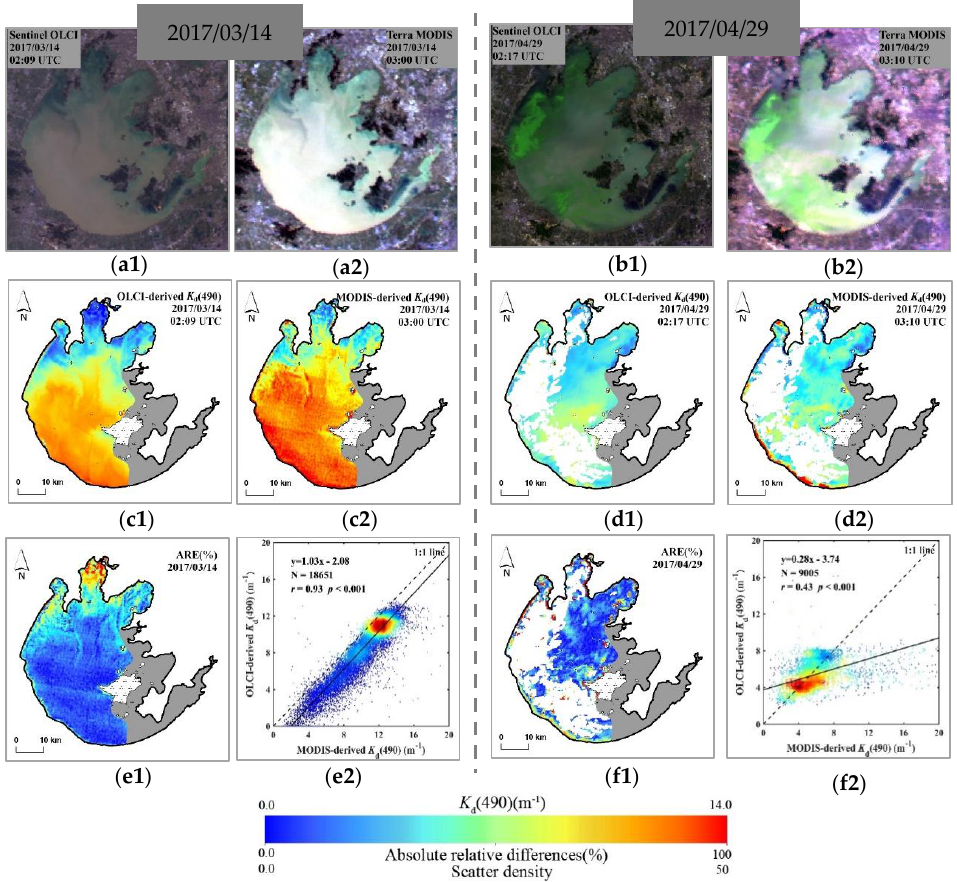
Figure 13. ( a , b ) OLCI and MODIS RGB images, ( c , d ) OLCI- and MODIS-derived K d (490) values, ( e , f ) absolute relative differences (ARE) and pixel-by-pixel scatter plots between the K d (490) products from the OLCI and MODIS on 14 March 2017, and 29 April 2017. Note that bad pixels were